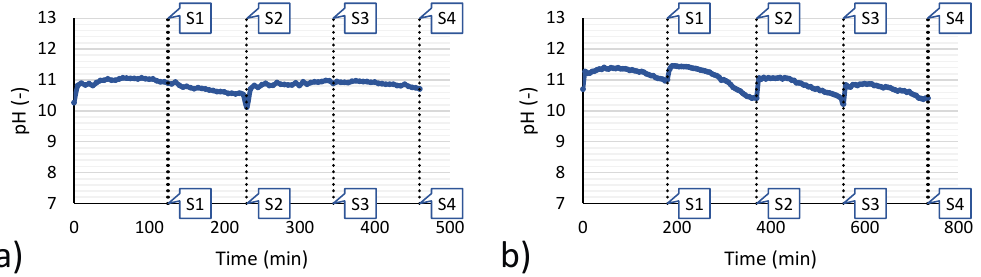
Figure 5. Time variation of pH during the feed & bleed tests. ( a ) test 3; ( b ) test 6. Vertical dotted lines indicate the time at which samples for analysis were taken (samples number is used as reference in Figure 6).